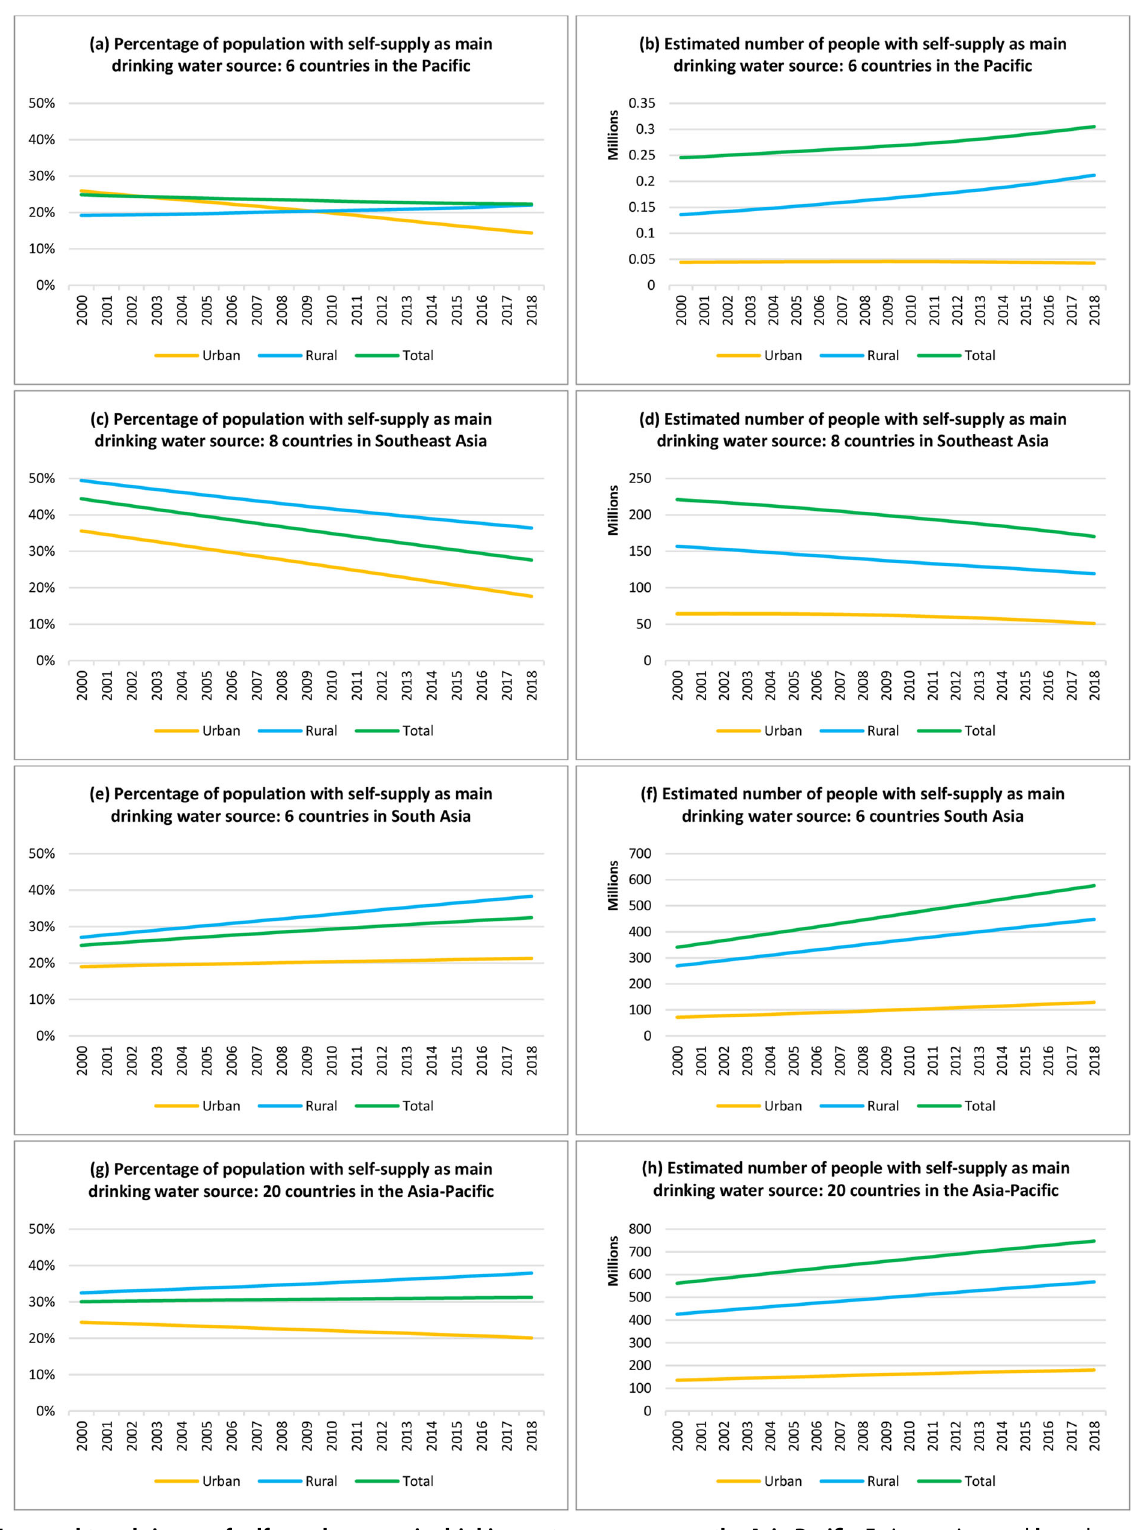
Fig. 6 Temporal trends in use of self-supply as a main drinking water source across the Asia-Paci fi c. Estimates in a and b are based on data from six countries in the Paci fi c (Micronesia, Samoa, Solomon Islands, Tonga, Tuvalu and Vanuatu). Data for Micronesia could not be disaggregated by urban – rural, and hence is only included in ‘ total ’ . Estimates in c and d are based on data from eight countries in Southeast Asia (Cambodia, Indonesia, Lao PDR, Myanmar, Philippines, Thailand, Timor-Leste and Vietnam). Estimates in e and f are based on data from six countries in South Asia (Bangladesh, India, Maldives, Nepal, Pakistan and Sri Lanka). Estimates in g and h are based on data from all aforementioned 20 countries (6 countries from South Asia, 8 countries from Southeast Asia and 6 countries from the Paci fi c).